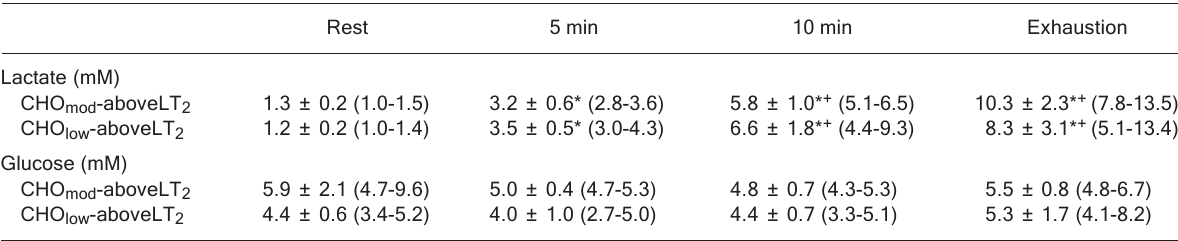
Table 3. Changes in blood lactate and glucose concentration as a function of time during exercise performed above the second lactate breakpoint by subjects with normal or depleted